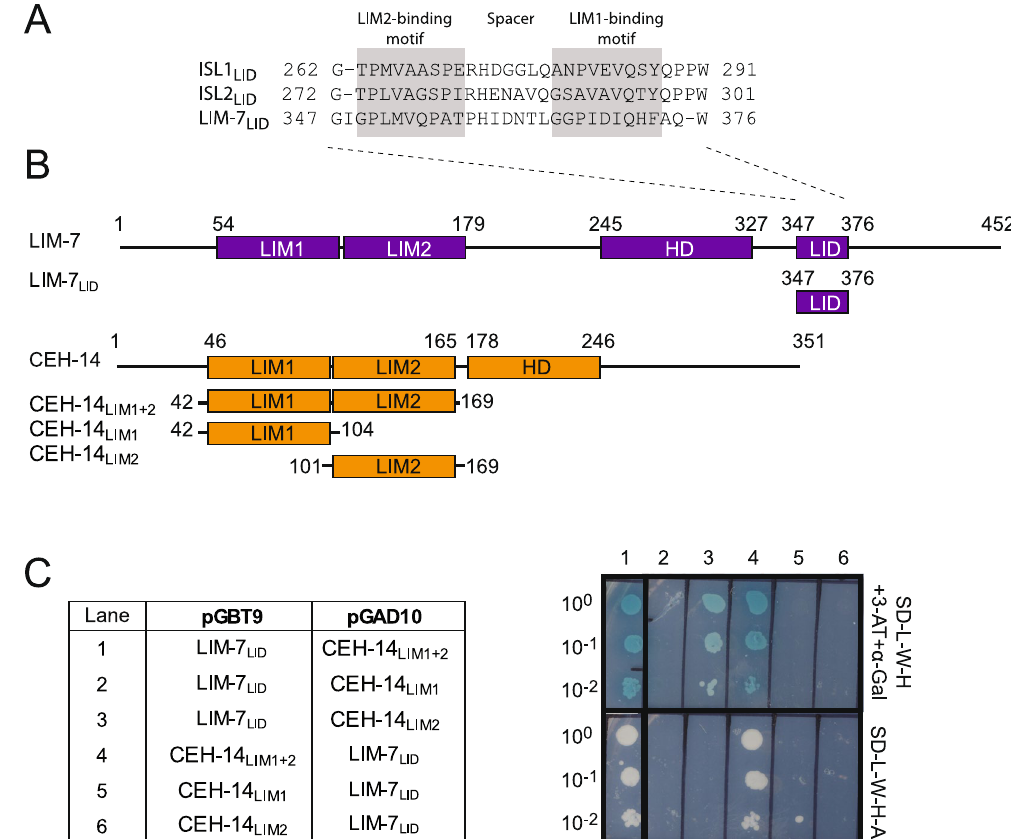
Figure 2. Islet- and LHX3-family LIM-HD proteins from C. elegans interact. ( A ) Manual alignment of experimentally determined LIM-interaction domains from mouse ISL1 and ISL2 and a predicted LID from LIM-7. The LIM1 and LIM2 binding motifs as previously identified for ISL1 and ISL2 are indicated; the spacer is the sequence between the binding motifs. ( B ) Schematics of LIM-7 and CEH-14 and constructs used in yeast two-hybrid (Y2H) assays showing the LIM1 and LIM2, homeodomain (HD) and predicted LIM interaction domain (LID). ( C ) Y2H data indicate a direct interaction between LIM-7 LID and CEH-14 LIM1 + 2 . The original images for the yeast plates, including additional controls are shown in Supplemental data Figure